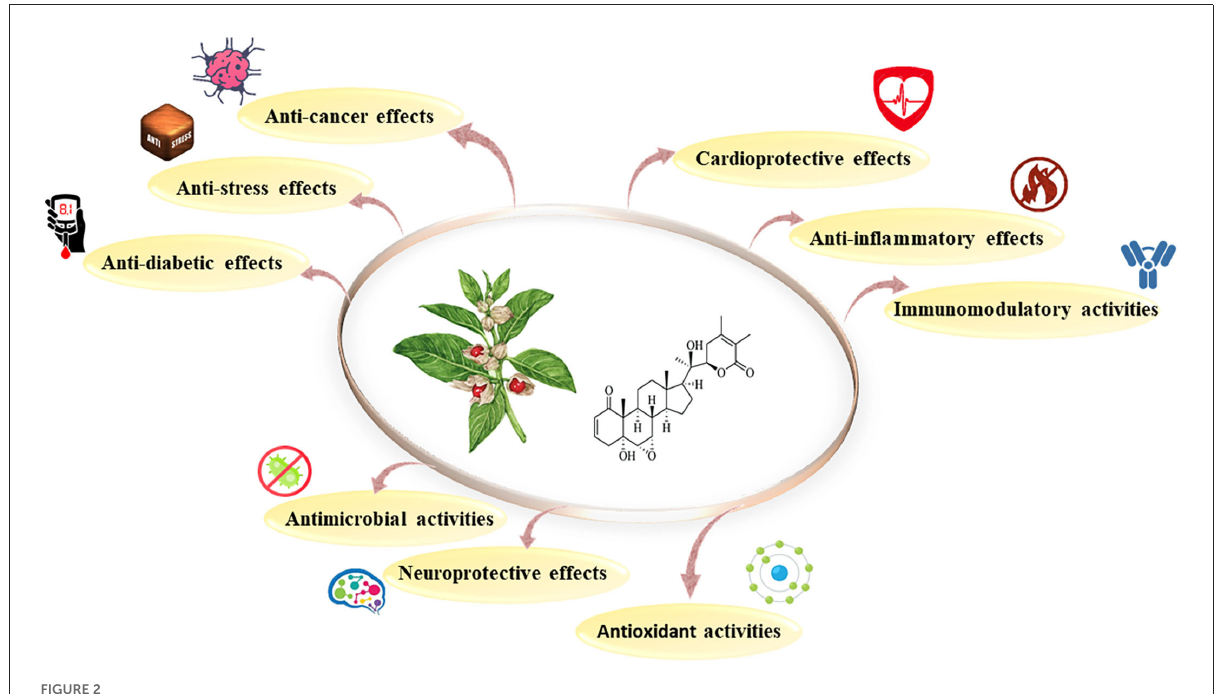
FIGURE2 Pharmacological features of Withania somnifera